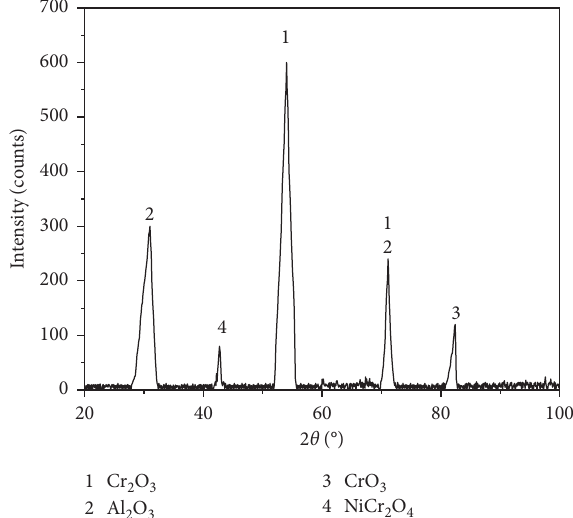
Figure 5: XRD pattern of the surface oxide film of NiCoCrAlY coating with 2% CeO 2 oxidized at 1050 ° C for